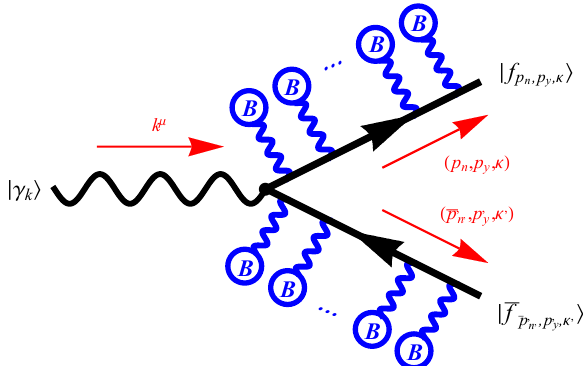
Figure 1 . The photon-to-di-lepton vertex in a magnetic field (3.1). The wave functions of the produced fermion and anti-fermion are non-perturbatively dressed by the magnetic field.